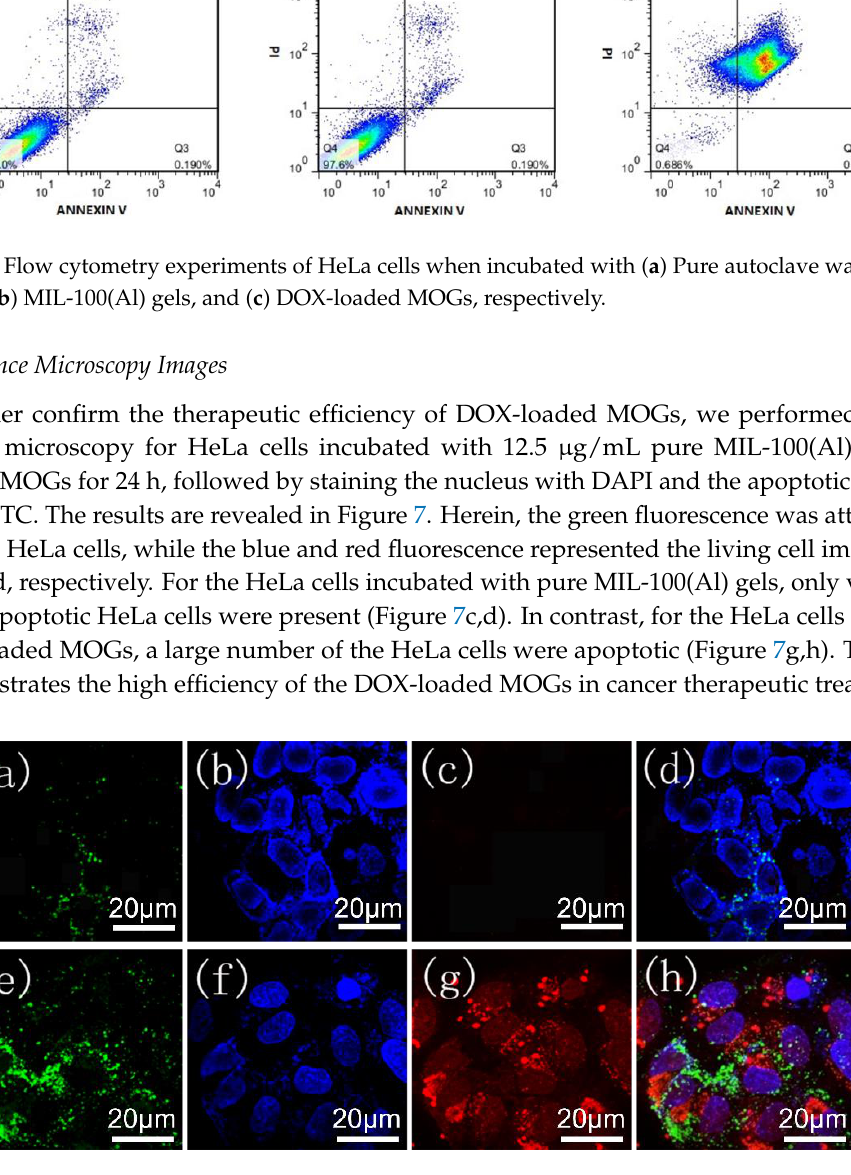
Figure 7. Confocal microscopy images of HeLa cells incubated with 12.5 μg/mL ( a – d ) MIL-100(Al) gels and ( e – h ) DOX-loaded MOGs, respectively. Blue fluorescence represents the living cell imaging. Red fluorescence represents the released DOX from DOX-loaded MOGs within the cancer cells. Green fluorescence represents the apoptosis of cells. ( d , h ) are the merged images of ( a – c ) and ( e – g ), respectively.